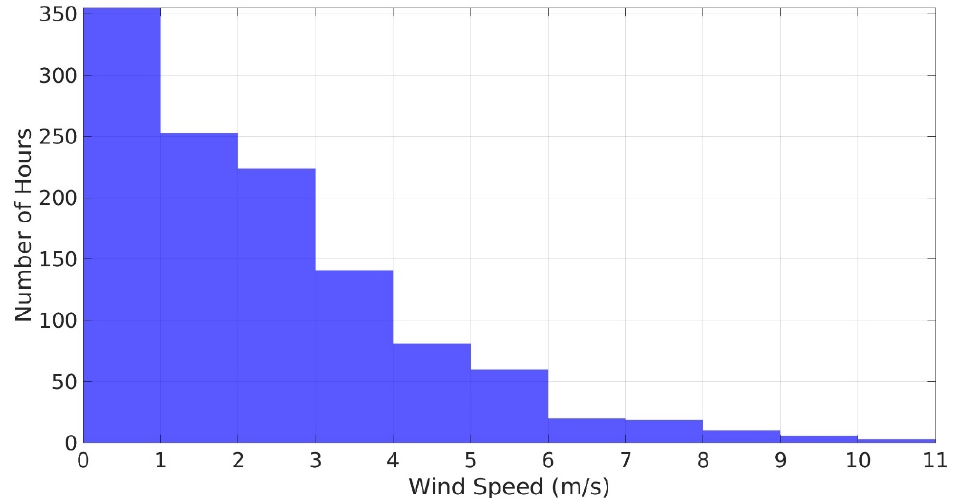
Figure 7. Histogram of microbarom detections as a function of wind speed measured at the nearby Mesonet station.